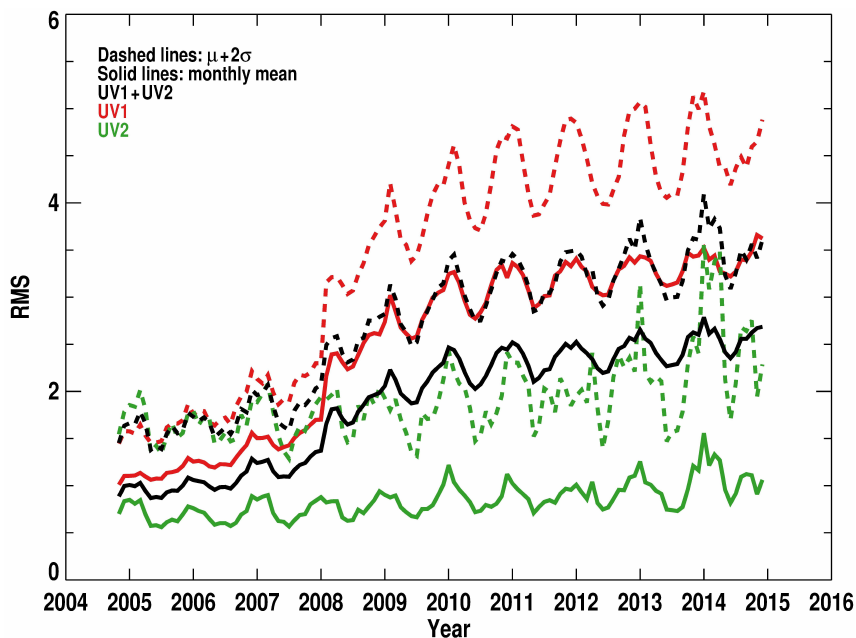
Figure 1. Variation of monthly mean OMI RMS (defined as root mean square of the ratio of radiance residuals to assumed radiance errors). The dashed and solid lines represent, respectively, the monthly mean RMS and the sum of monthly mean plus its two standard deviations that is set as the RMS threshold for data